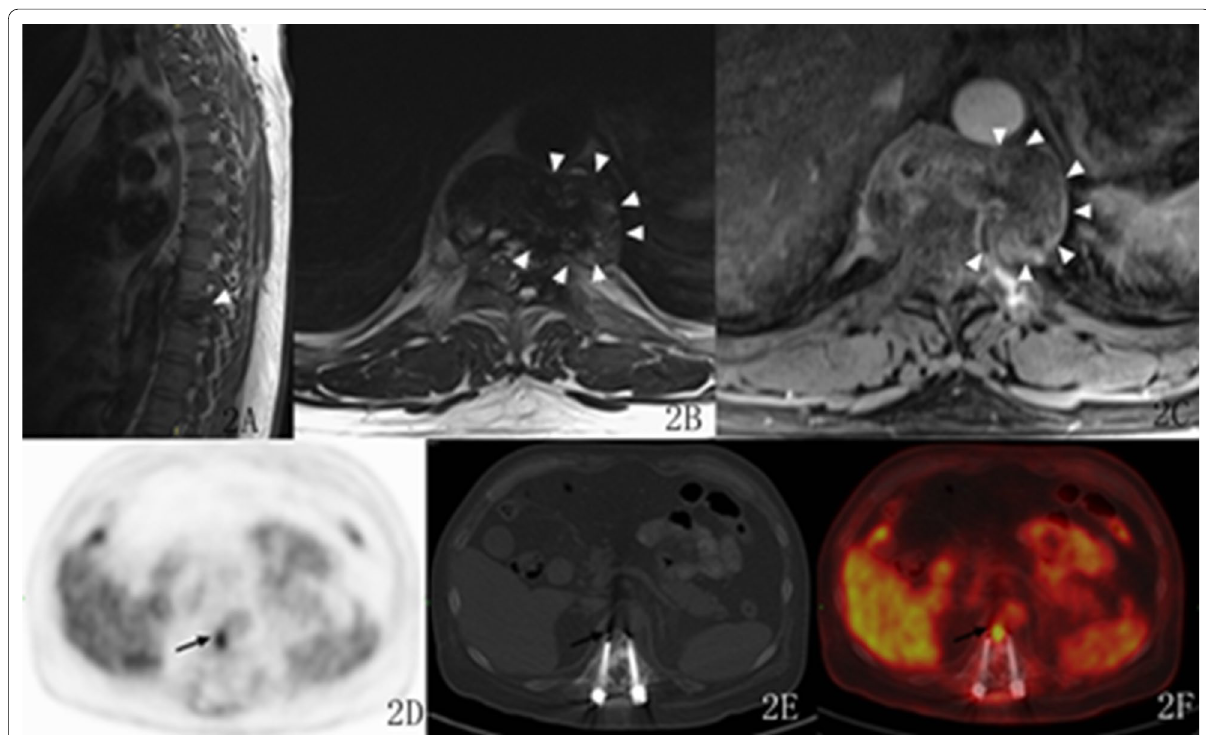
Fig. 2 A 45-year-old male with benign GCTTS. The lesion was hypointense on T1WI ( A , arrow) and mostly hypointense on T2WI in the T9 vertebra ( B , arrows). Enhanced MRI scans revealed heterogeneous enhancement ( C , arrows). Recurrence was suspected after surgery, and PET showed high 18 F-FDG uptake in the vertebral body ( D , arrow). The lesion was blurred on CT because of the interference from artefacts ( E , arrow), but the fusion image clearly showed the high 18 F-FDG-uptake lesion at the anterior edge of the T11 vertebra ( F